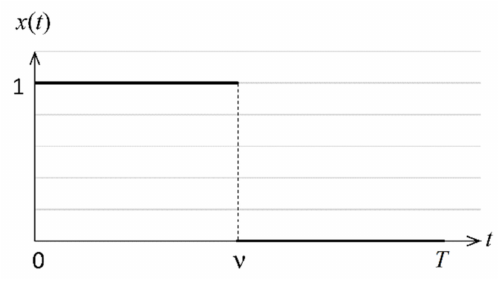
Figure 2. The form of the input signal